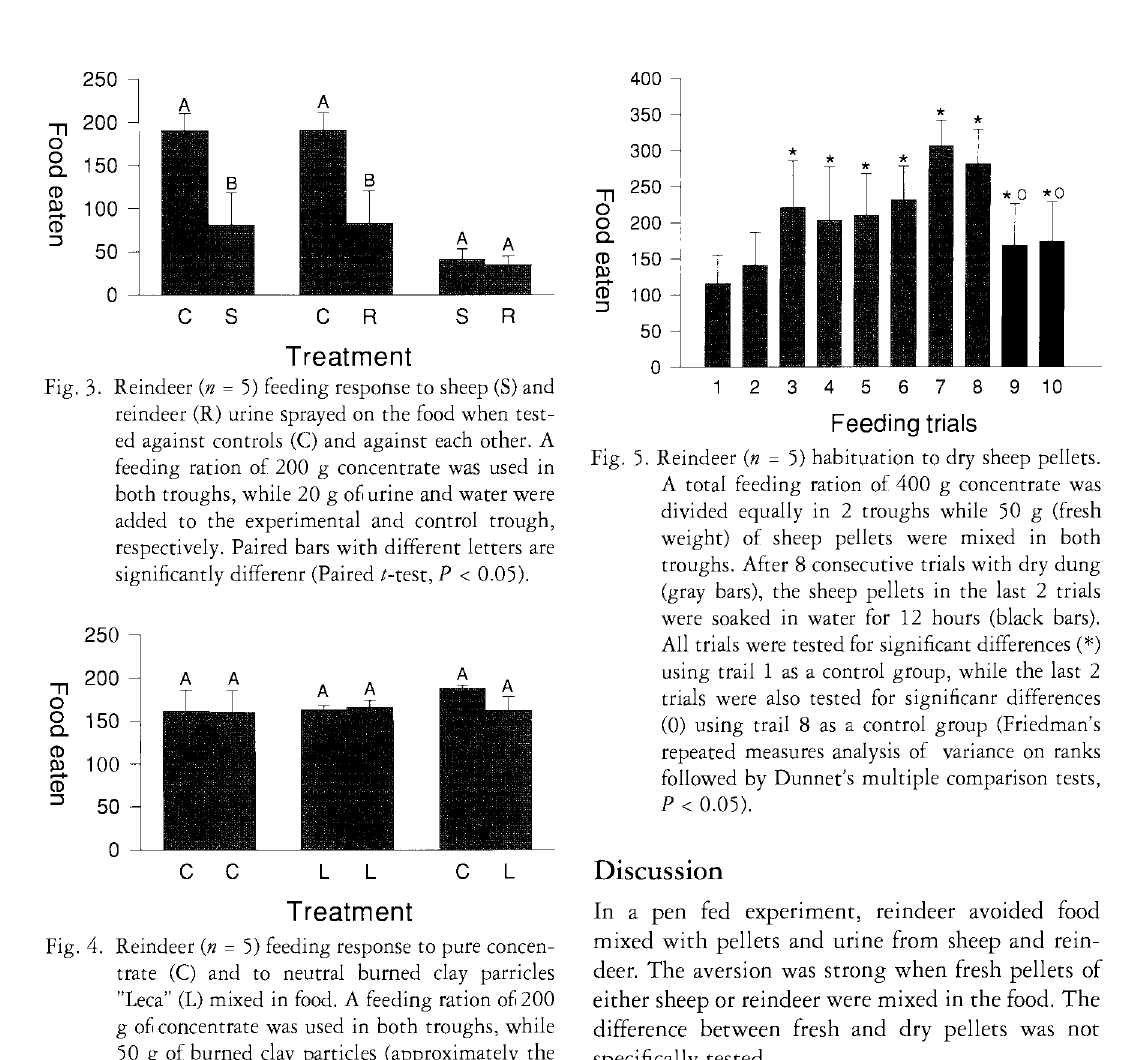
Fig. 5. Reindeer (n = 5) habituation to dry sheep pellets. A total feeding ration of 400 g concentrate was divided equally in 2 troughs while 50 g (fresh weight) of sheep pellets were mixed in both troughs. After 8 consecutive trials with dry dung (gray bars), the sheep pellets in the last 2 trials were soaked in water for 12 hours (black